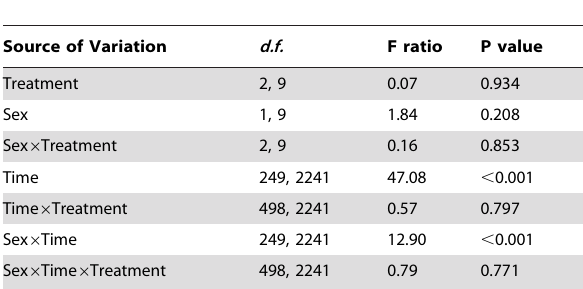
Table 4. Variation in male and female activity levels